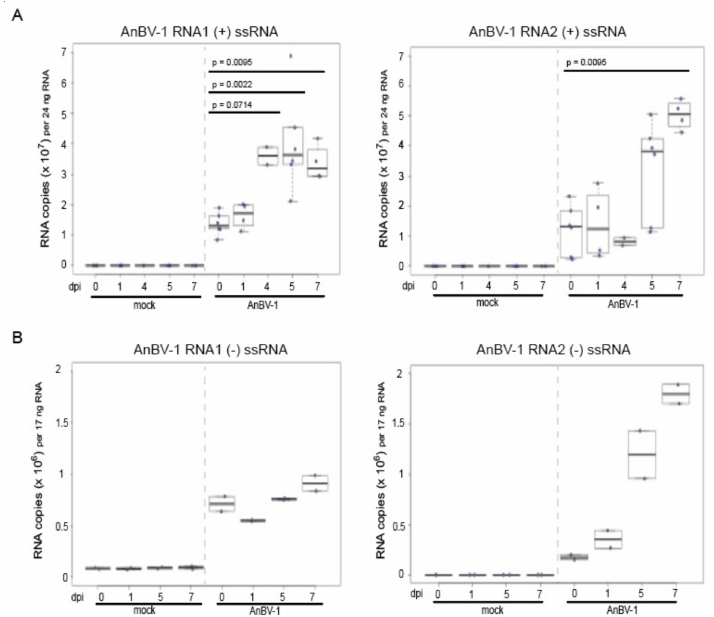
Figure 5. AnBV-1 replicates in honey bee pupal cells. To examine the ability of AnBV-1 to replicate in primary honey bee cells, cultures of pupal cells were incubated with AnBV-1-negative lysate (mock) or AnBV-1-positive lysate (AnBV-1). Total RNA was isolated from each cell culture well at 0, 1, 4, 5, or 7 days post-infection (dpi) and virus replication was assessed via strand-specific reverse transcription followed by qPCR. ( A ). Quantification of positive-strand, including both genome copies and transcripts, of AnBV-1 RNA 1 and AnBV-1 RNA 2 at each designated dpi. For RNA 1, 3.6 × 10 7 +/ − 2.9 × 10 6 copies per 24 ng RNA at 4 dpi vs. 1.4 × 10 7 +/ − 1.5 × 10 6 copies per 24 ng RNA at 0 dpi. For RNA 2, 5 × 10 7 +/ − 2.5 × 10 6 copies per 24 ng at 7 dpi vs. 1.2 × 10 7 +/ − 3.4 × 10 6 copies per 24 ng RNA at 0 dpi. ( B ). Quantitative assessment of negative-strand, replicative intermediate forms of AnBV-1 genome segments at each designated dpi; AnBV-1 RNA 1 and AnBV-1 RNA 2. Data were analyzed using R Studio and p -values were calculated using a pairwise Wilcoxon Rank Sums test with no multiple comparisons correction, and sample sizes per time point ranged from 2 to 6 samples. Relative quantity of the housekeeping gene Amrpl8 was consistent across all samples at all time